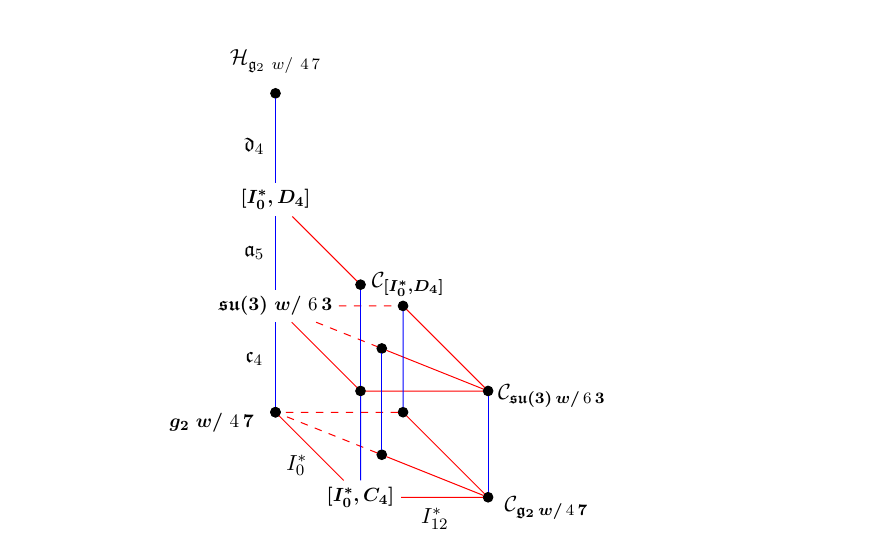
Figure 26. The Hasse diagram for the full moduli space of the g 2 theory with 4 hypermultiplets in the 7